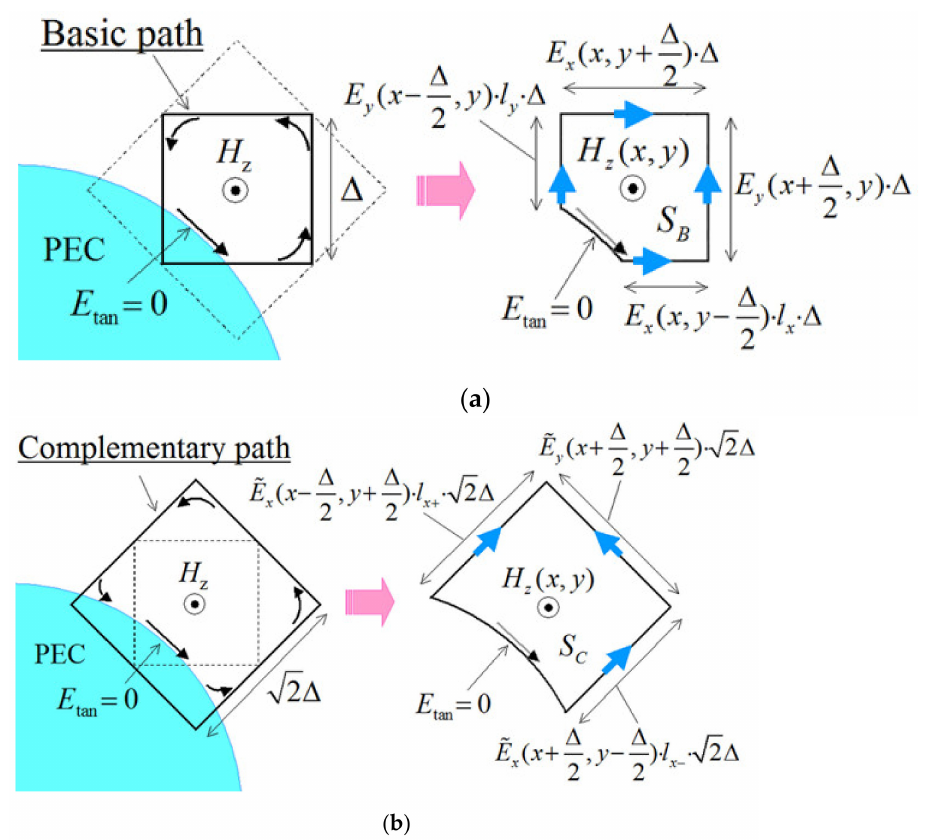
Figure 3. Modified integral paths for the proposed PI model based on (Figure 1a) and (Figure 1b), respectively. ( a ) Basic path and ( b ) complementary path. Dashed lines represent the position of the pair paths, PEC areas are indicated in light blue, and l x , y = l pathlength / ∆ signifies the ratio of the path length over ∆ . Note that the integral path and the area for the calculation of the H z magnetic field component form a part, except for the PEC region, indicated at the right side of the figure. The treatment of the path integrals in Equations (4) and (5) is based on the same principles as those in the FDTD